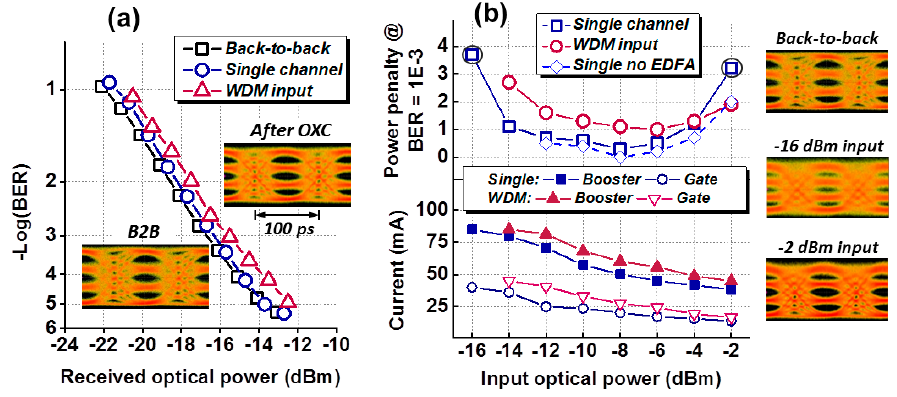
Figure 14. ( a ) BER curves and ( b ) the dynamic range with adjusted SOA current for 20 Gb/s PAM4 traffic.